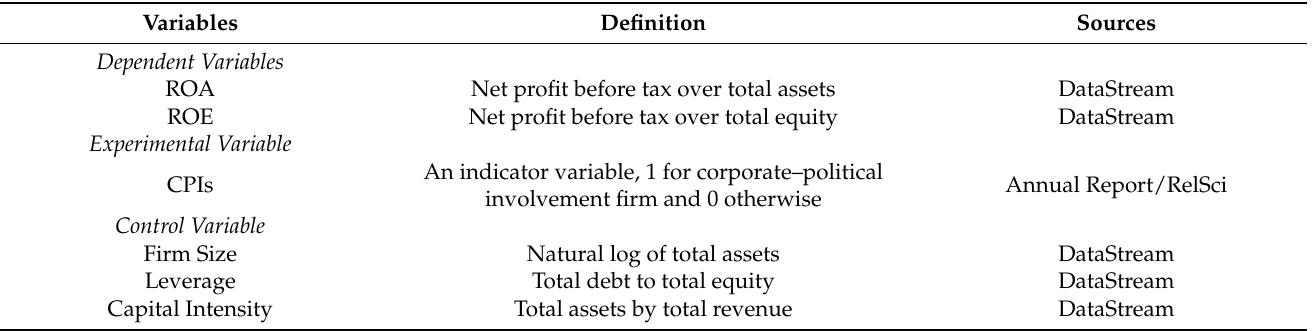
Table 4. Summary of measurement